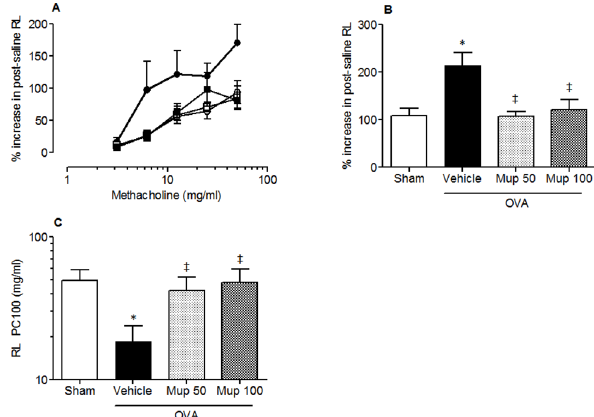
Fig 7. Effect of Muparfostat on OVA induced changes in lung function. Graphs showing (A) % increase in total lung resistance versus methacholine dose in sham immunized ( (cid:2) ), OVA sensitized in vehicle-treated ( ● ) or OVA-immunized mice treated with Muparfostat 50 mg/kg (Mup, □ ) or Muparfostat 100 mg/kg (Mup, ■ ) s. c. before being challenged with aerosolised 3% OVA for 4 consecutive days, (B) peak percentage increase in post saline resistance, (C) R L provocative concentration (PC)100 for methacholine. Each point or columns represent mean ± SEM n = 8 – 11, p < 0.05 versus sham * or vehicle ‡ . Data obtained from four independent